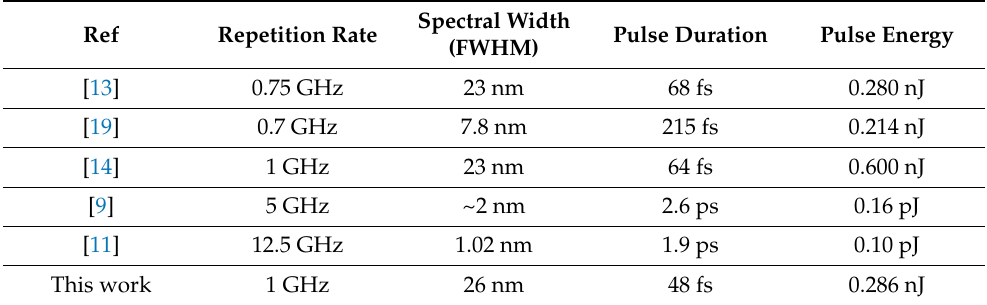
Table 1. Comparison of output pulse duration for high-repetition-rate mode-locked fiber lasers.